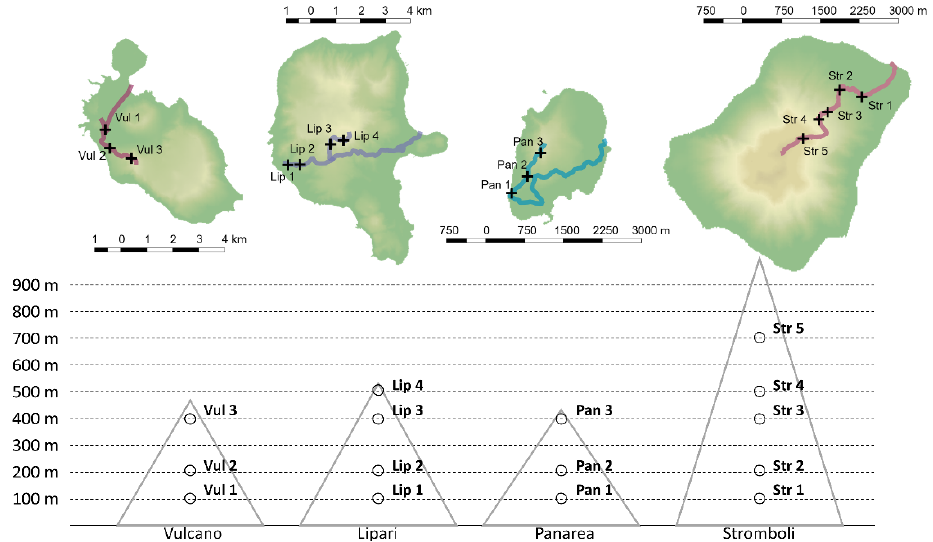
Figure 3. Collection sites. Map of the islands created in QGIS 2.18.20 (QGIS Development Team, 2016) using the DEM file provided by ISPRA and the shape file provided by ISTAT.